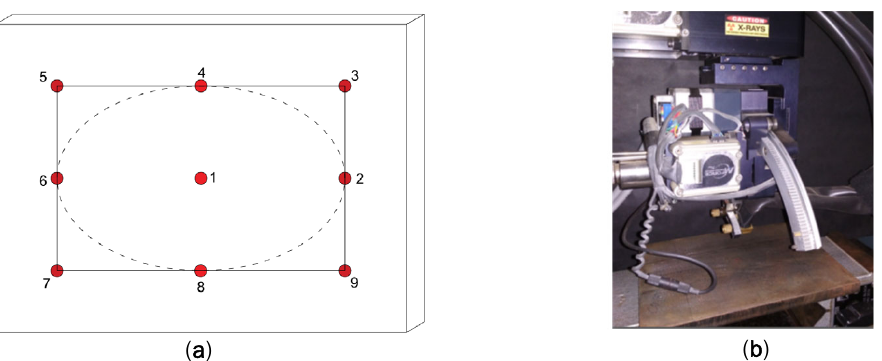
Figure 4. ( a ) Bottom view of baseplate and locations for measurement of residual stresses; ( b ) Setup for the residual stress measurement.